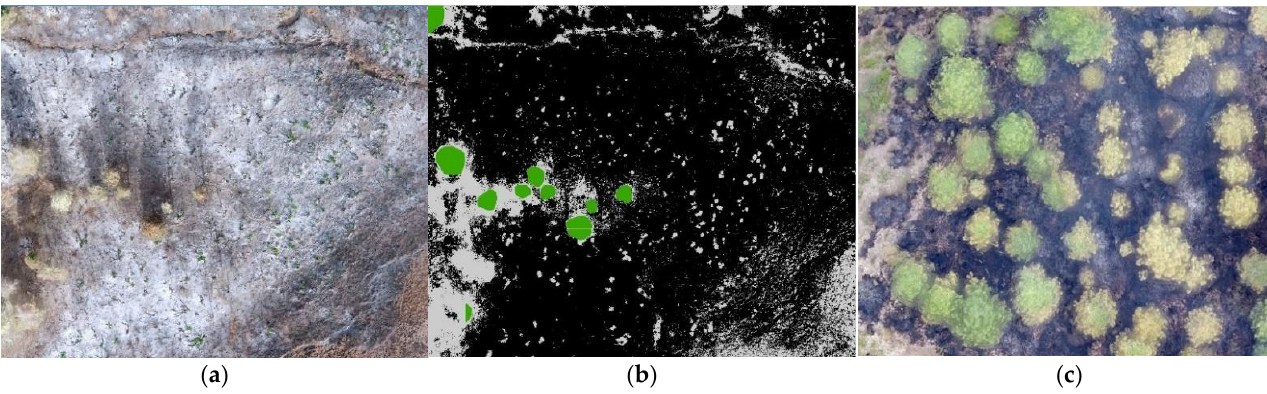
Figure 8. ( a ) An example from the Mesa fire that shows low canopy cover. ( b ) This figure shows a mostly identified burn extent without the need for Sub-Crown Burn Reclassification using the imagery from ( a ). ( c ) An example from the Hoodoo fire that shows high amounts of canopy cover with low